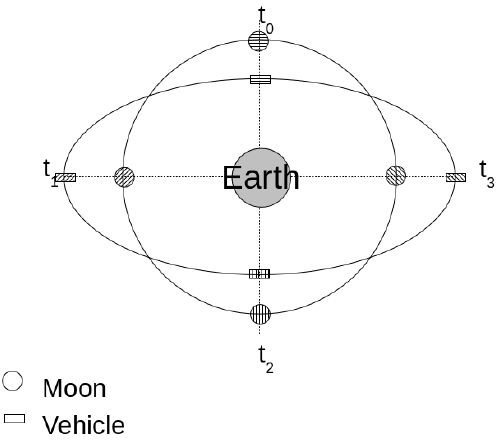
Figure 2. Illustration of the 1:1:2 resonance. The illustrated trajectories are shown in the Earth-centered inertial